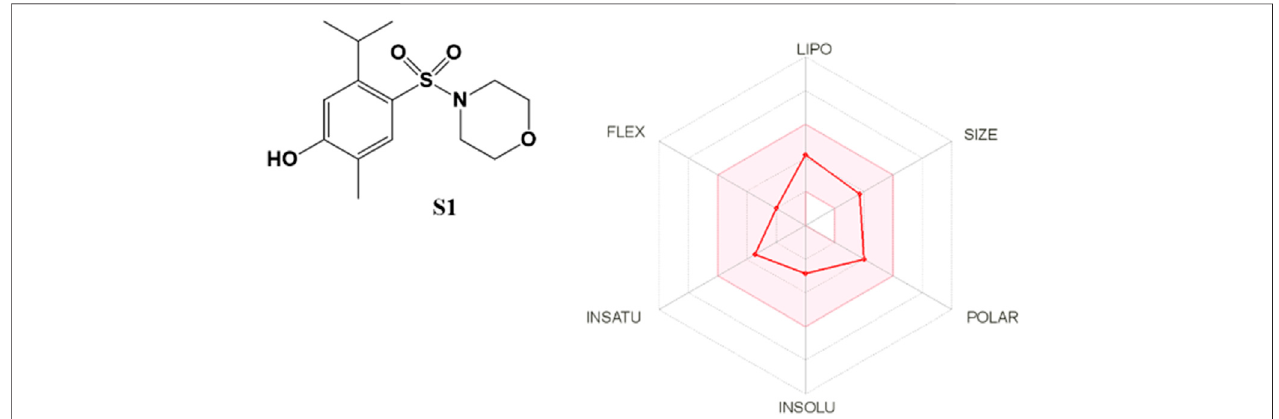
FIGURE 10 | The Bioavailability Radar for S1 . The fi gure was generated online using SwissADME. Compound S1 combines good hydrophobicity and solubility, which is vital for membrane transport and permeability. Also, it does not violate any of the fi lters proposed by Lipinski, Ghose, Veber, Egan, and Muegge ( Figure 11 ).